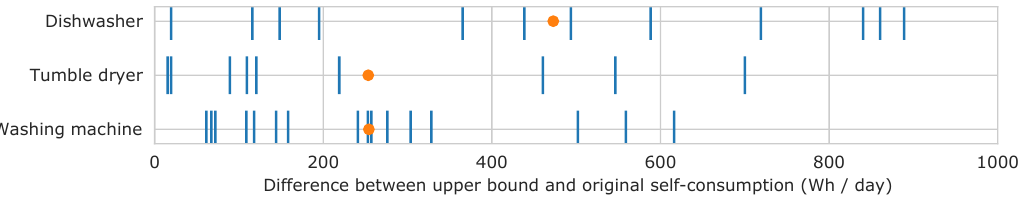
Figure 4. Self-consumption upper bound for each appliance and household. Values are the difference between the upper bound and the self-consumption before load shifting. The orange dots mark the mean.